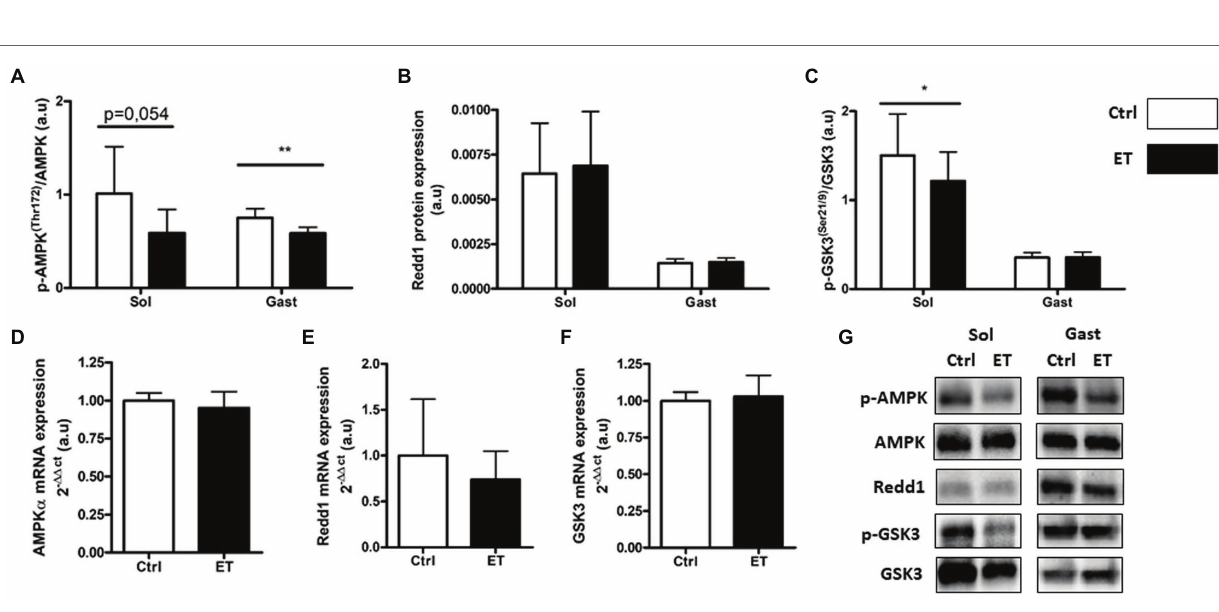
FIGURE 7 | Ergothioneine effect on metabolic stress markers 2 h after exercise. Metabolic stress markers in soleus and gastrocnemius muscle and expression of genes encoding metabolic markers in gastrocnemius muscle. (A) Phosphorylated AMPKa (Thr172)/total AMPKa ratio. (B) Redd1 protein expression. (C) Phosphorylated GSK3 (Ser21/9)/total GSK3 ratio. (D) AMPKa mRNA level. (E) Redd1 mRNA level. (F) Gsk3 mRNA level. (G) Representative Western Blots; * p < 0.05; ** p <0.01 vs.